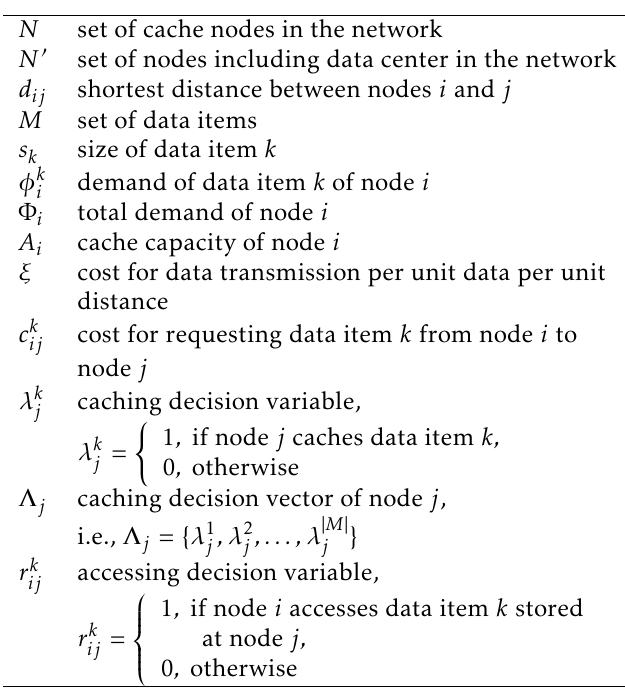
Table 1. Notationused in the